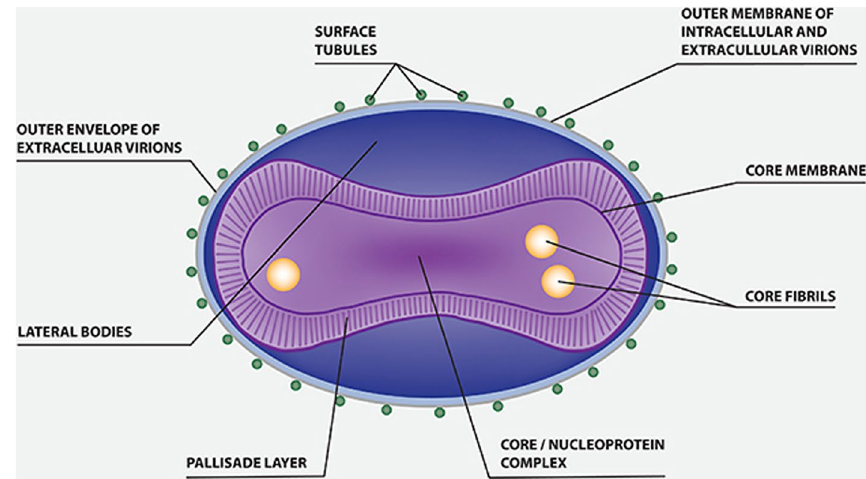
Fig. 1 Structure of monkeypox